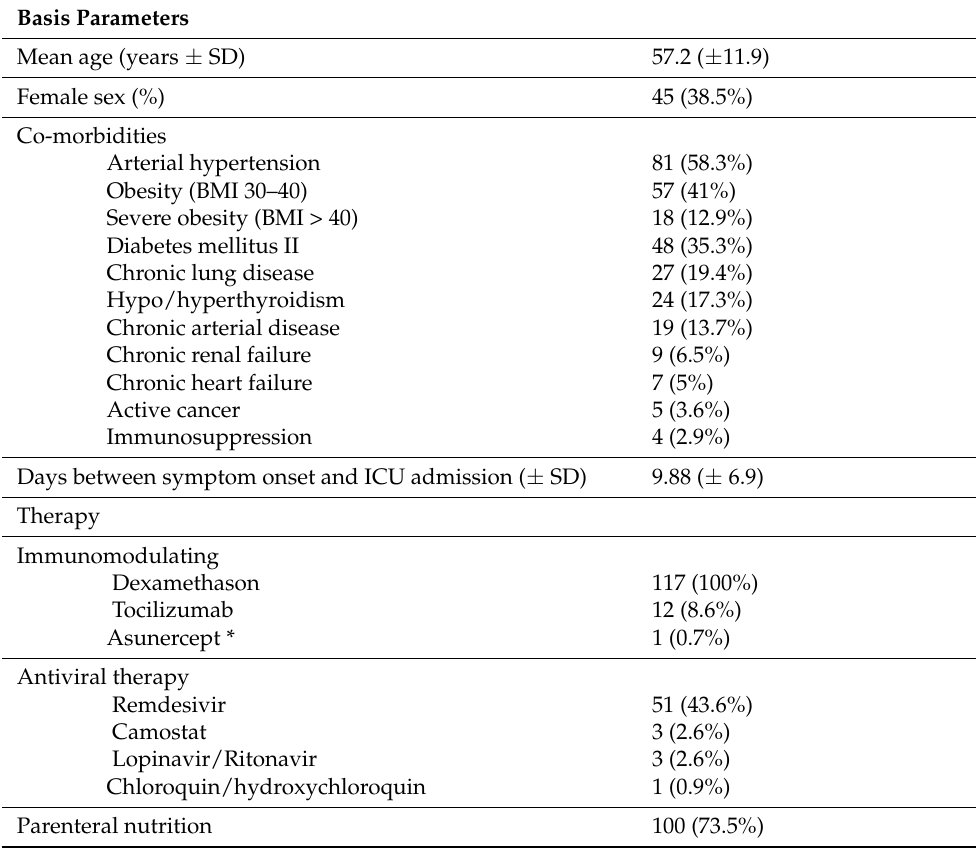
Table 1. Basic parameters and therapy of all 117 included patients. * Administrated as part of a clinical study.